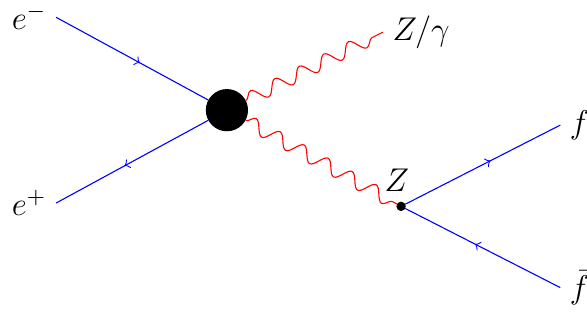
Fig. 1 Feynman diagram for production of Z boson and its decay to a pair of